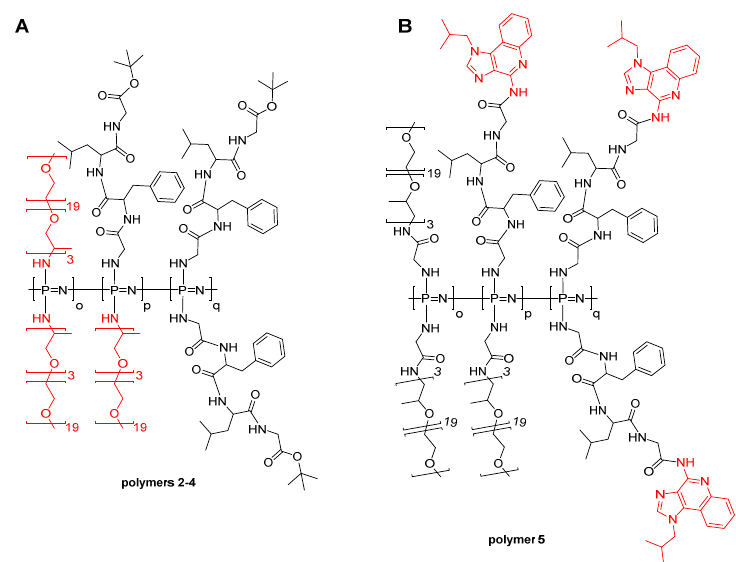
Figure 2. ( A ) Poly(organo)phosphazenes 2 – 4 with the tetrapeptide linker GFLG and Jeffamine M-1000 coupled to the polyphosphazene backbone. ( B ) Poly(organo)phosphazene 5 loaded with imiquimod via the tetrapeptide linker GFLG and Jeffamine M-1000 coupled via a glycine spacer to the polyphosphazene backbone. The combinations of the two different side chains are statistically distributed.